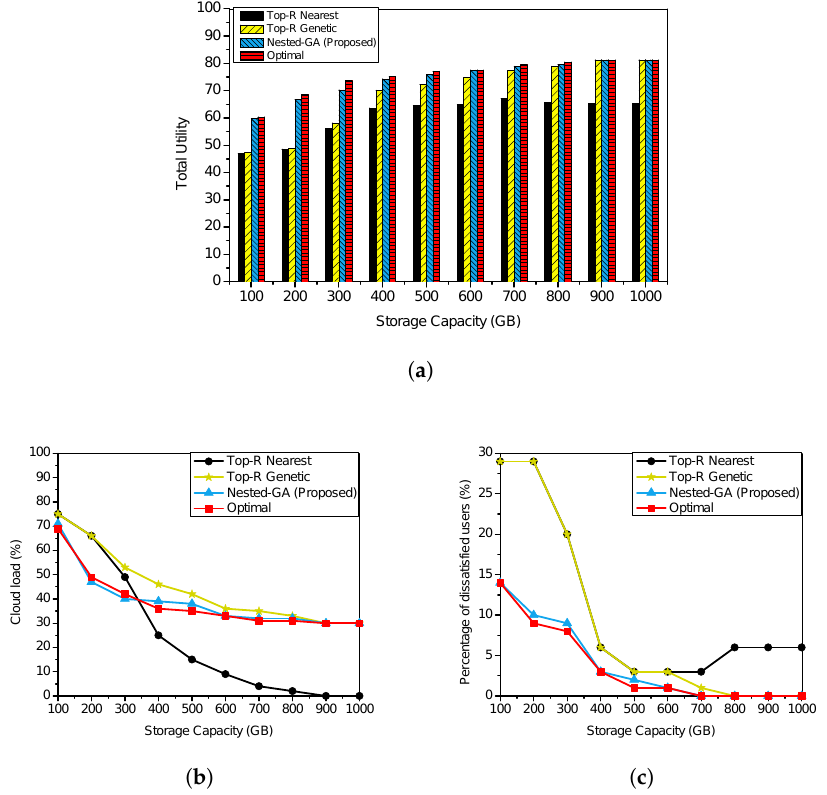
Figure 7. ( a ) Total utility; ( b ) Cloud load; ( c ) Percentage of dissatisfied users versus storage capacity of